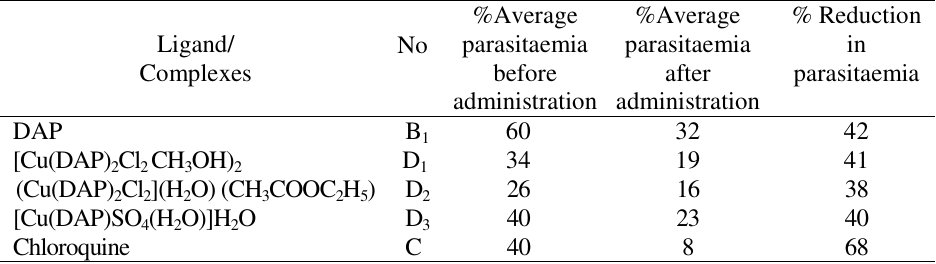
Table 6 . Percentage parasitaemia of DAP and its metal complexes Ligand/